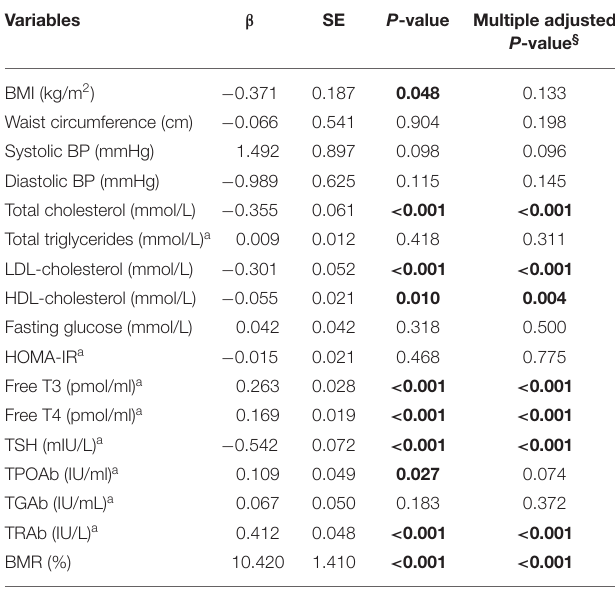
TABLE 3 | Clinical correlates of serum Tsukushi levels with clinical and biochemical variables.